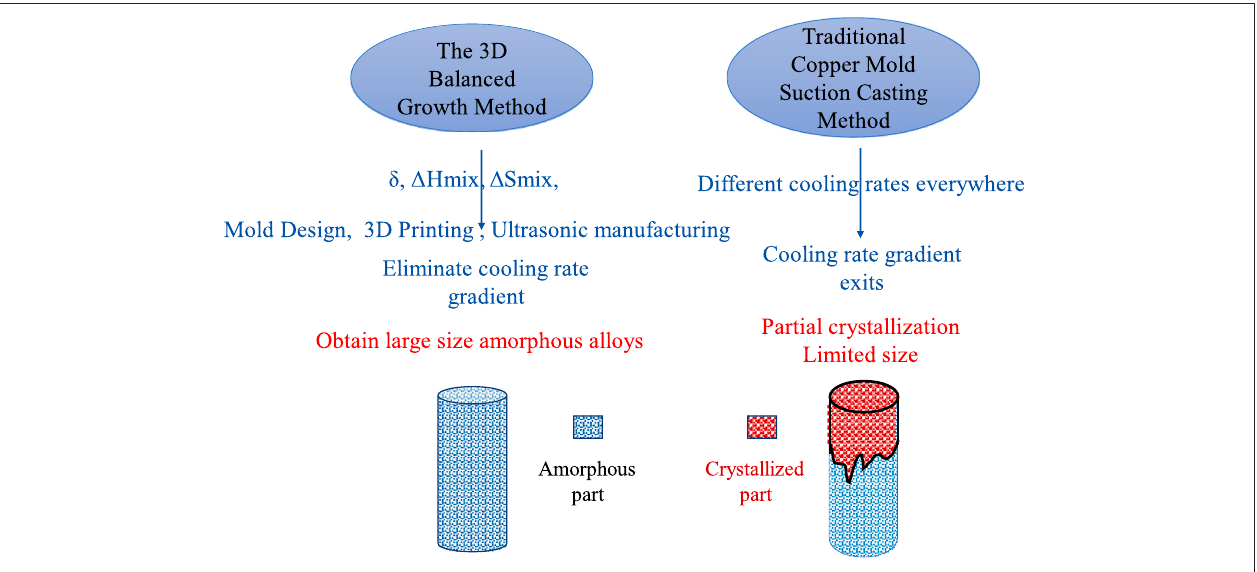
FIGURE 9 | Comparison between the three-dimensional balanced growth method and traditional copper mold suction casting.